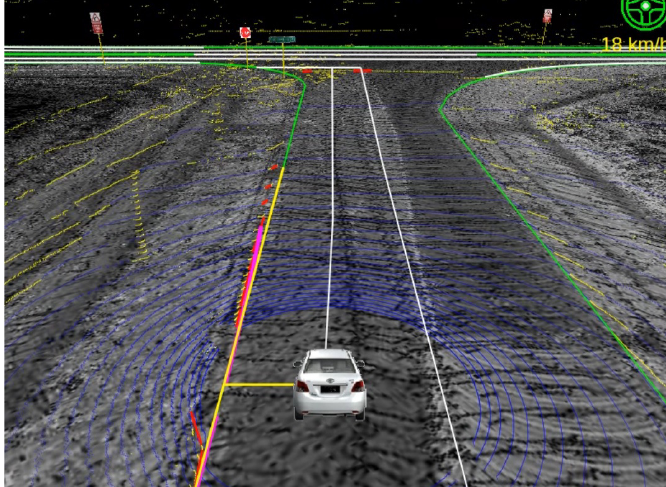
Figure 13. Localization result with lateral correction.